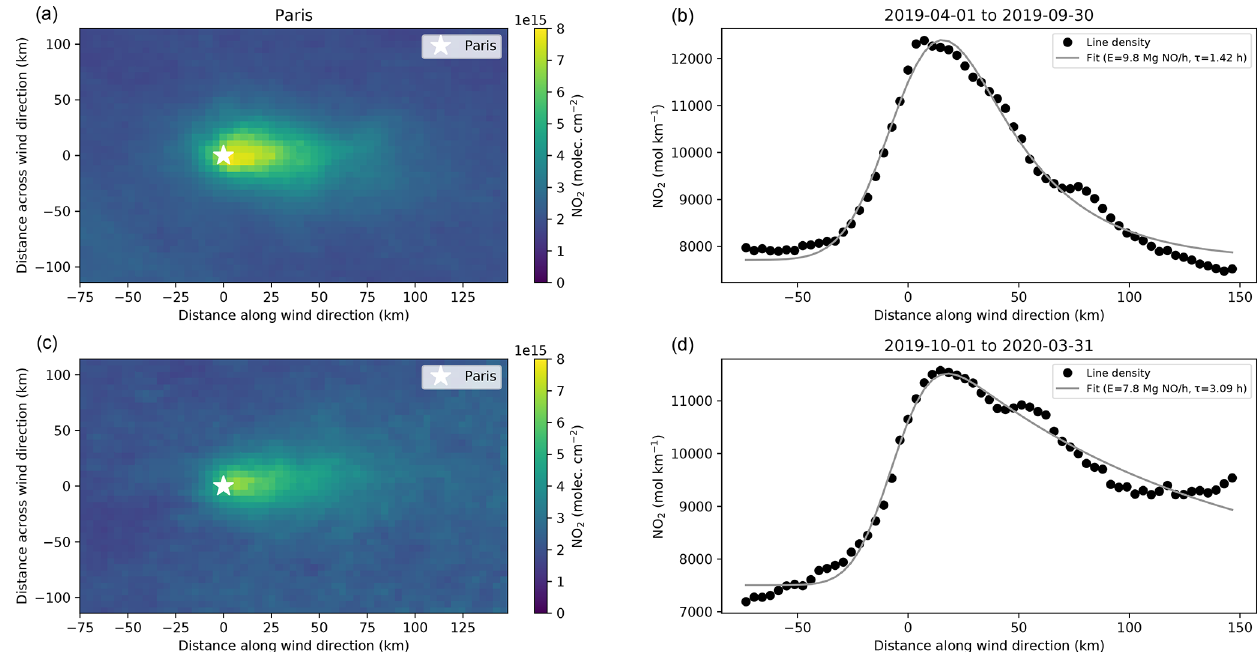
Figure B1. Example of lifetime fitting using Paris for demonstrative purposes. Panels (a) and (b) show summer fits, and panels (c) and (d) show winter fits, with the specific dates used given in the title of (b) and (d) . Panels (a) and (c) show the average NO 2 column density after aligning wind direction (right is downwind). Panels (b) and (d) show the line densities (black circles) and fits (grey lines) computed from the wind-aligned column